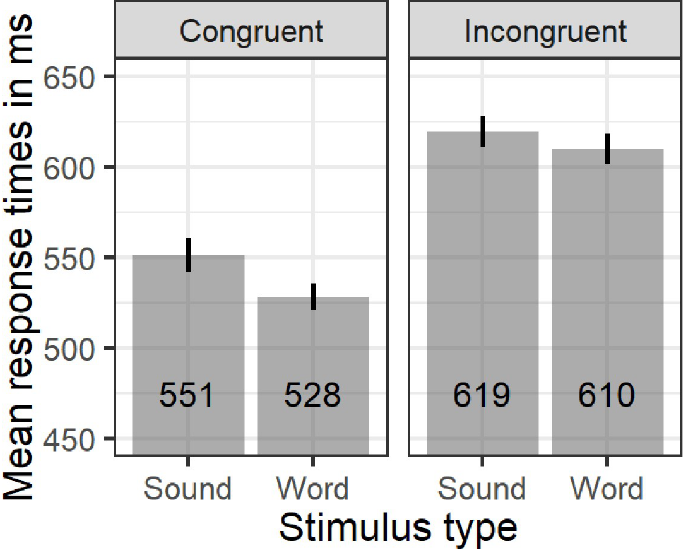
Fig 1. Mean response times (aggregated by participants) as a function of stimulus type and congruency. Error bars without caps represent standard error of the means (SE).